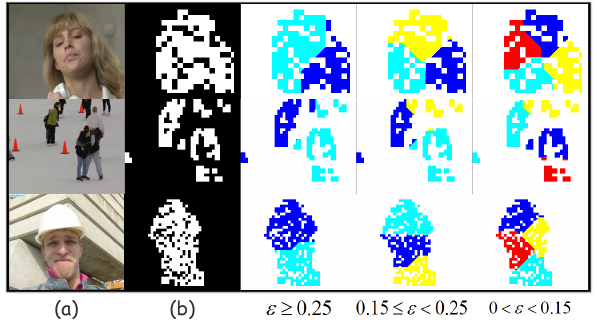
Figure 7. The motion segmentation results for different values of ε ( K max = 4): ( a ) Raw sequences. (From top to bottom: Suzie , Ice , Foreman ) ( b ) Foreground motion